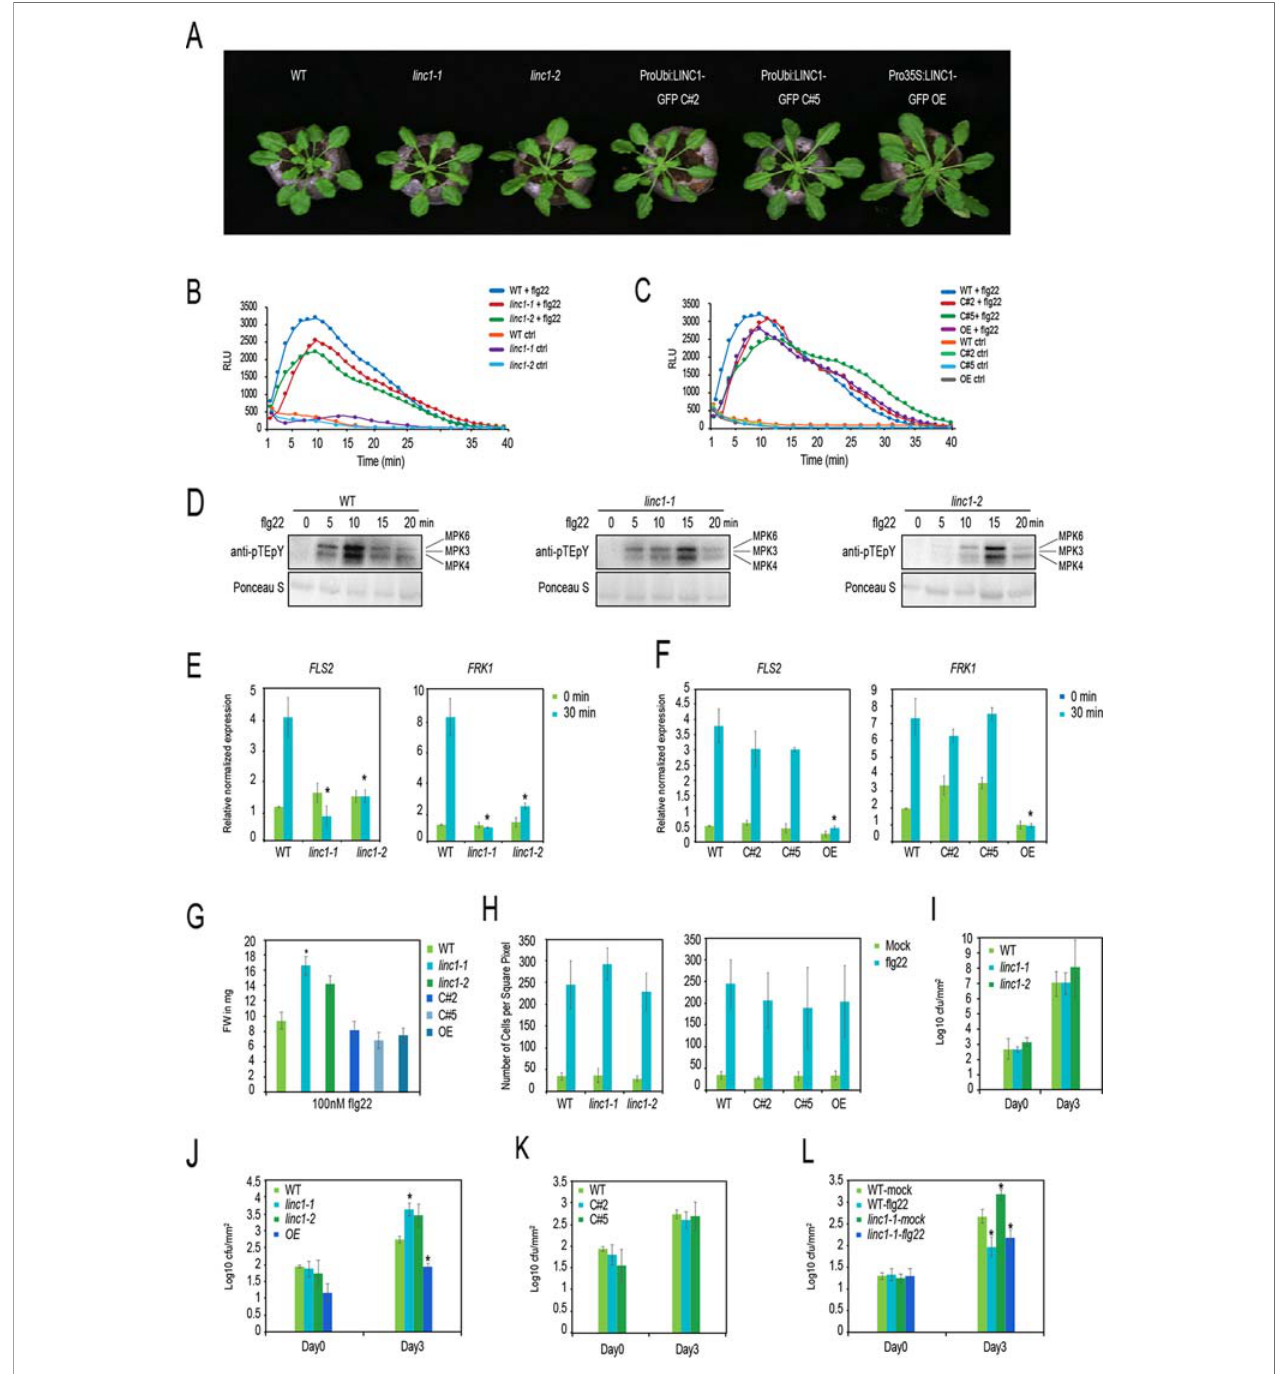
FIGURE 1 | LINC1 regulates early and late PTI responses. (A) Morphological phenotypes of 4-week old jiffy grown plants. (B) fl g22-induced ROS burst over 40 min in leaf discs of 5-week old plants WT, linc1-1 , linc1-2 plants and (C) in WT, C#2, C#5, OE plants. (D) fl g22-induced MAPK activation in WT, linc1-1 and linc1-2 plants. (E , F) FLS2 and FRK1 marker gene expression in 10-day old seedlings treated with 1 µM fl g22 for 30 min of WT, linc1-1, linc1-2 plants and in WT, C#2, C#5, OE plants. (G) fl g22-induced seedling growth inhibition of WT, linc1-1 , linc1-2 , C#2, C#5, and OE plants. (H) fl g22-induced callose deposition in WT, linc1-1, linc1-2, C#2, C#5, and OE plants. (I) Bacterial population evaluated in 4-week old WT, linc1-1 , linc1-2 plants after 3 and 72 hpi with Pst DC3000 at an OD 600 nm = 0.02. (J) Bacterial population evaluated in 4-week old WT, linc1-1 , linc1-2 , and OE plants after 3 and 72 hpi with Pst hrcC - at an OD 600nm = 0.02. (K) Bacterial population evaluated in 4-week old WT, C#2 and C#5 plants after 3 and 72 hpi with Pst hrcC at an OD 600 nm = 0.02. (L) Bacterial population evaluated in 4-week old WT and linc1-1 plants pretreated with water or 1 1 µM fl g22 for 24 hours and then challenged with Pst DC3000 at an OD 600 nm = 0.02 after 3 and 72 hpi. Flg22 priming of WT and linc1-1 plants with fl g22 at 24 h before Pst hrcC- infection. The data are shown in (E – L) are means from three biological replicates with a two-way Anova. Asterisk indicates a signi fi cant difference with P < 0.05 when compared with the wild